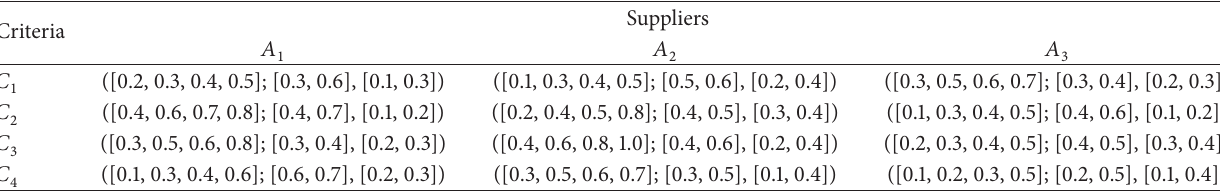
Table 1: Assessment by DM 1 .